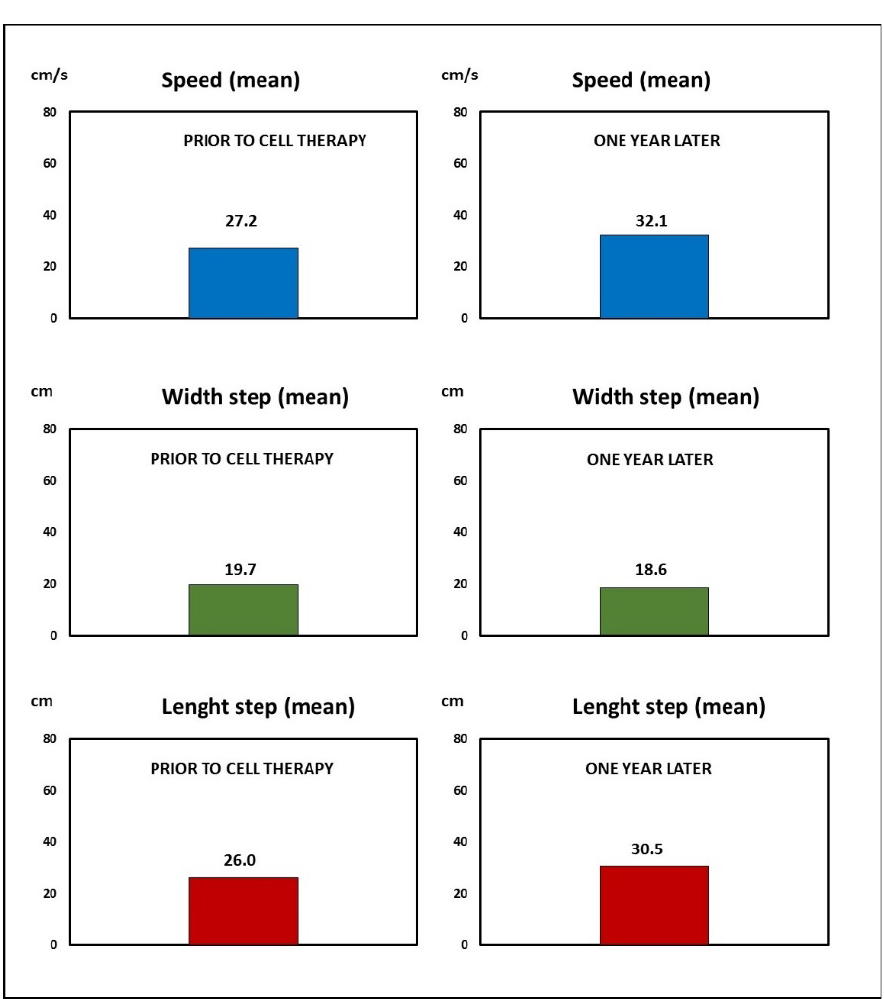
Figure 2. Case 1: The improvement obtained by cell therapy in the gait analysis. Scores in the Kroght [20] and Geffner [21] scales showed no changes at the end of follow-up. In the ASIA assessment [22], modifications in sensitivity or motor scores were also not observed at the end of the study, but in neurophysiological studies, improvements in parameters of motor evoked responses after transcranial magnetic stimulation were recorded (Table